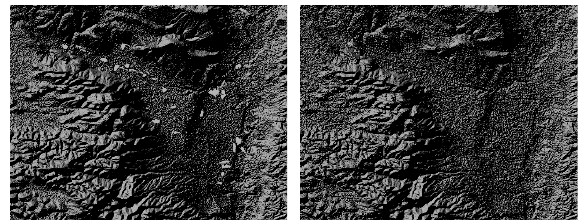
Figure 1. Shaded relief representation of the same area by two distinctive DTM sources: SRTM (left) and Survey of Israel (right). SRTM presents a more rugged terrain, having more detailed features; however, it also has some